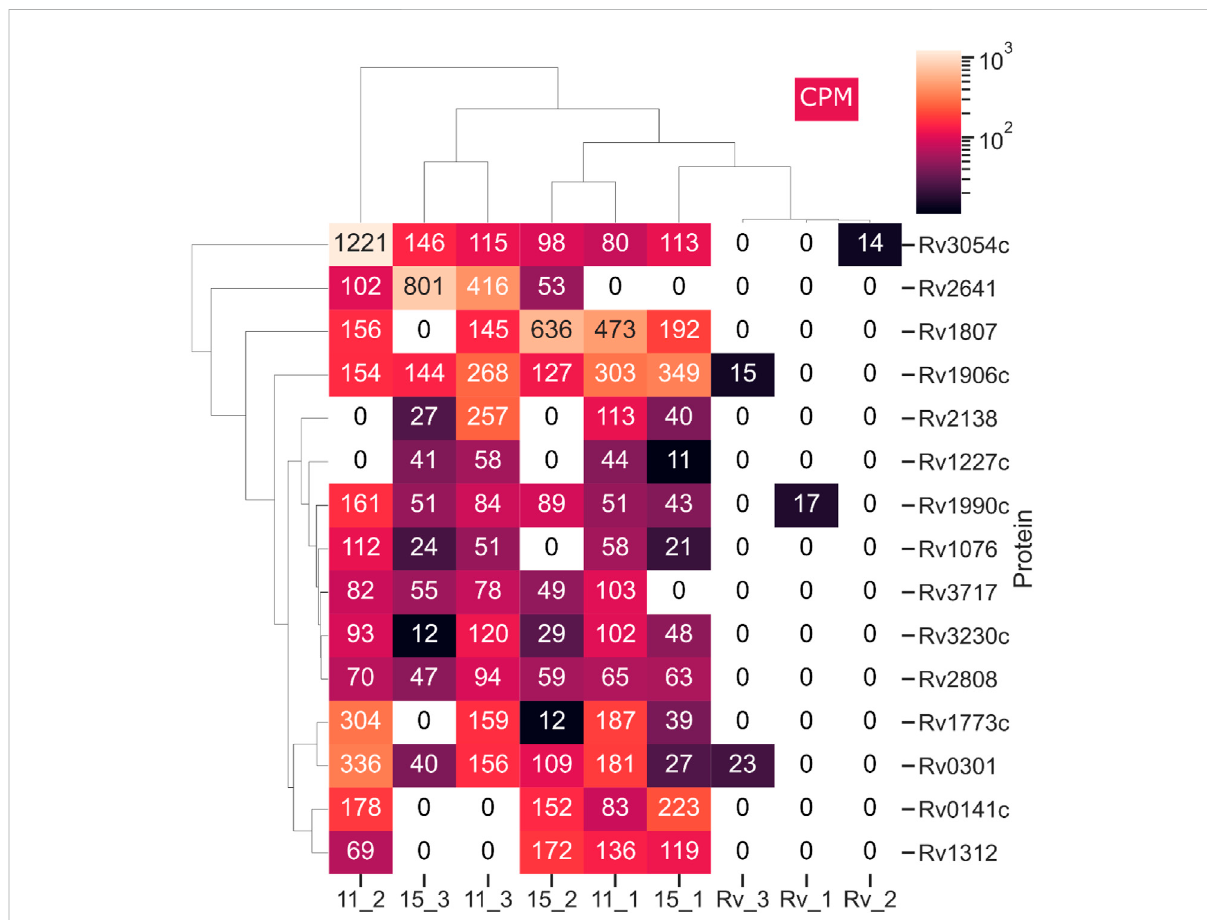
FIGURE 4 Proteins detectable by LC – MS/MS in M. tuberculosis treated with compounds 11 and 15 but not in the control, untreated cells. This heat map